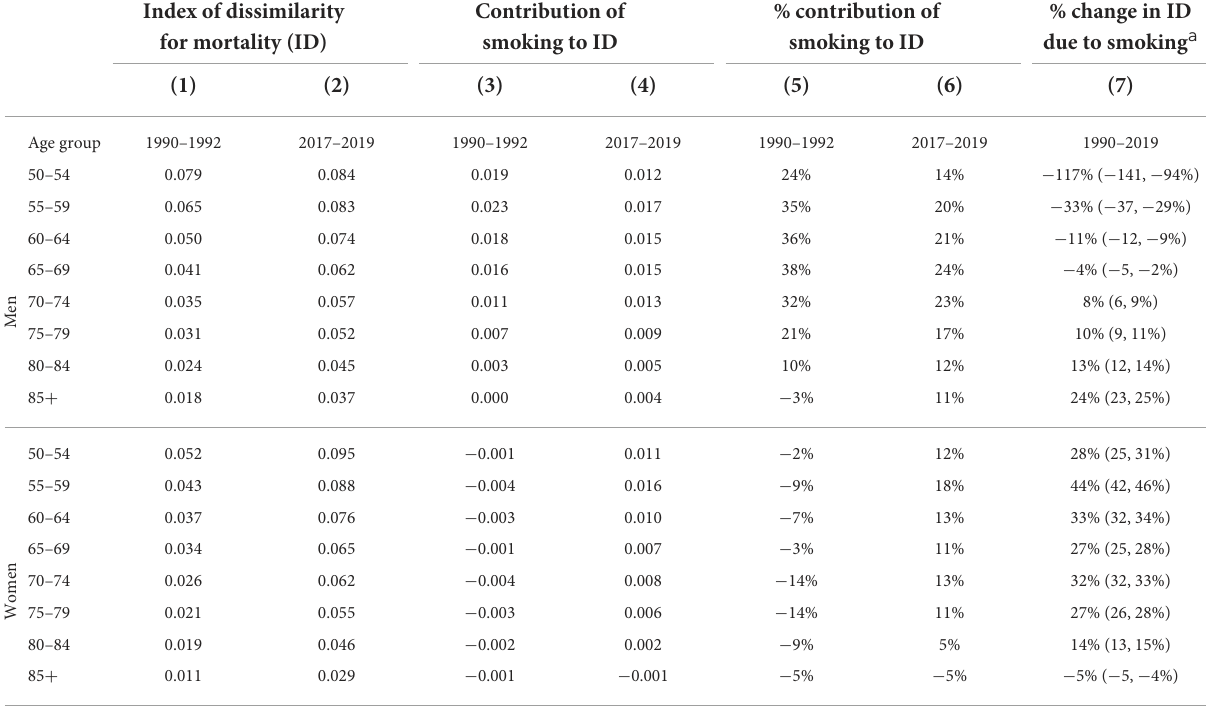
TABLE 2 Contribution of smoking-related deaths to geographic inequality in mortality by sex and age,